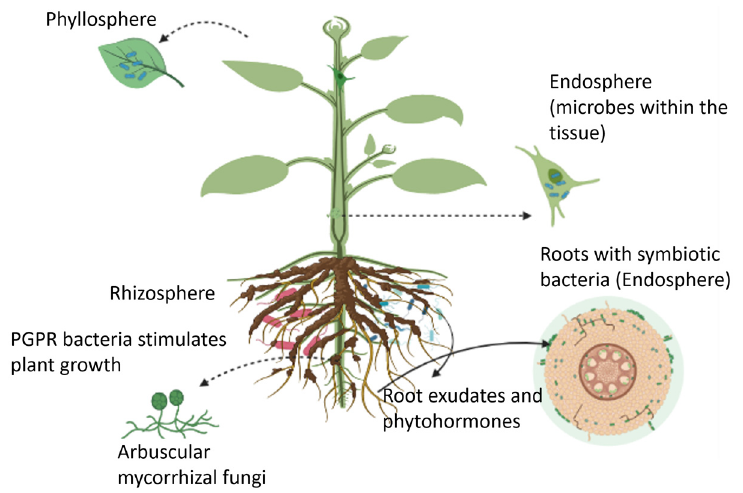
Figure 1. An overview of plant growth‑promoting microbes that reside in the rhizosphere, endosphere, and phyllosphere regions.